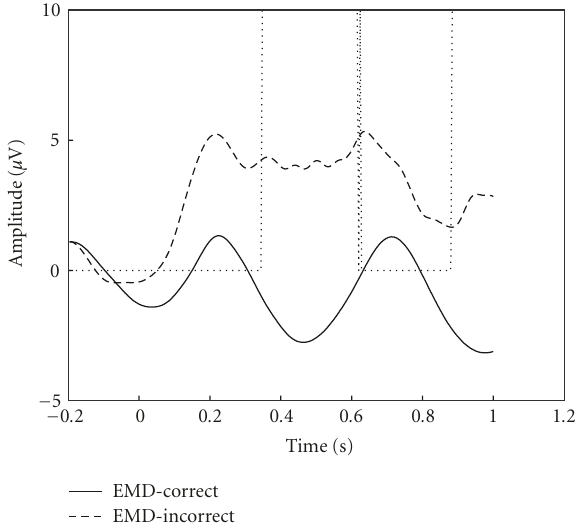
Figure 13: Comparison between averages of correct and incorrect trials lowpass filtered at 40Hz, from condition A. Dotted vertical lines indicate time points at which di ff erence between two condi- tions was significant ( P < .